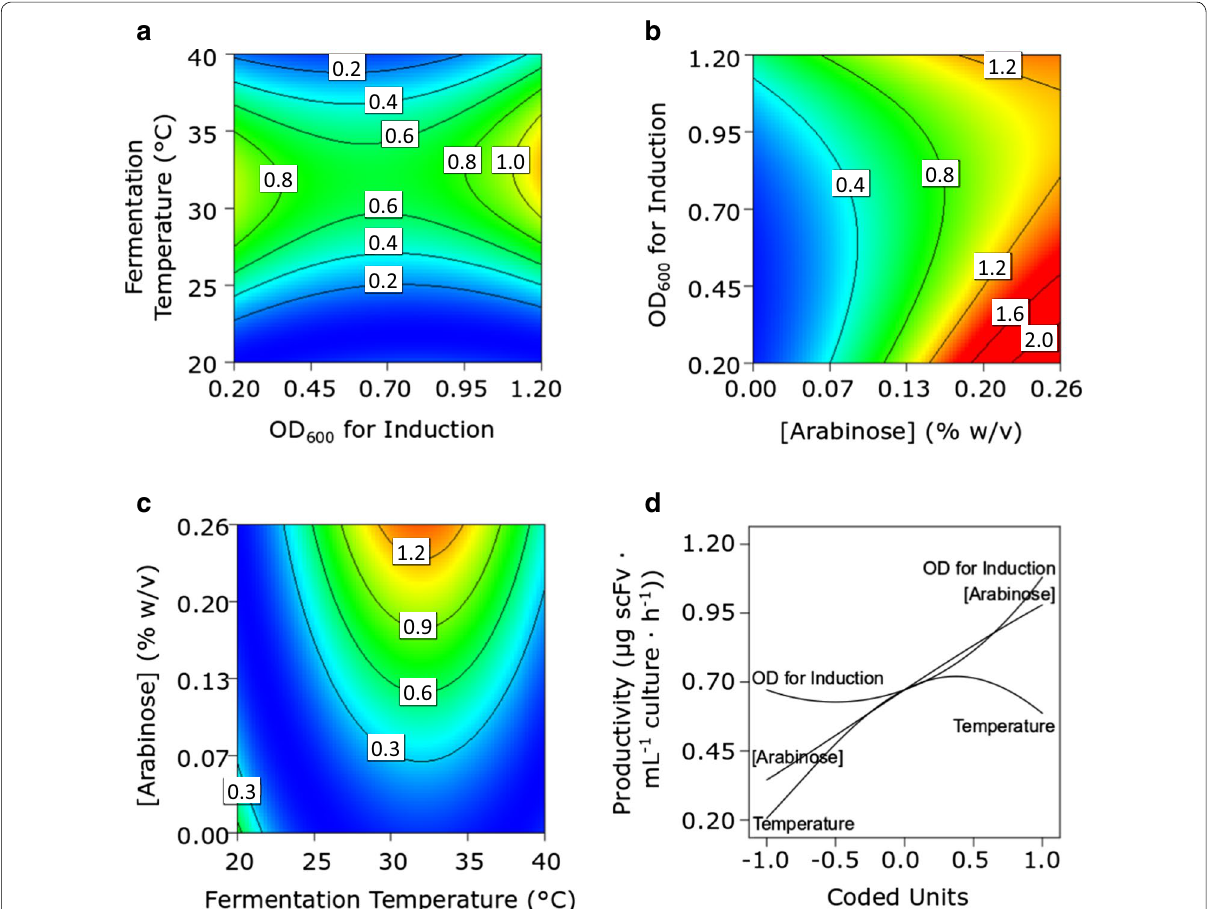
Fig. 2 Response ( a – c ) and perturbation ( d ) plots for the whole cell productivity of PelB sp -scFv. Response plots show the response of two factors; the third invariant factor is set at level ‘0’. Units in response plots are µg scFv mL 1 culture h −